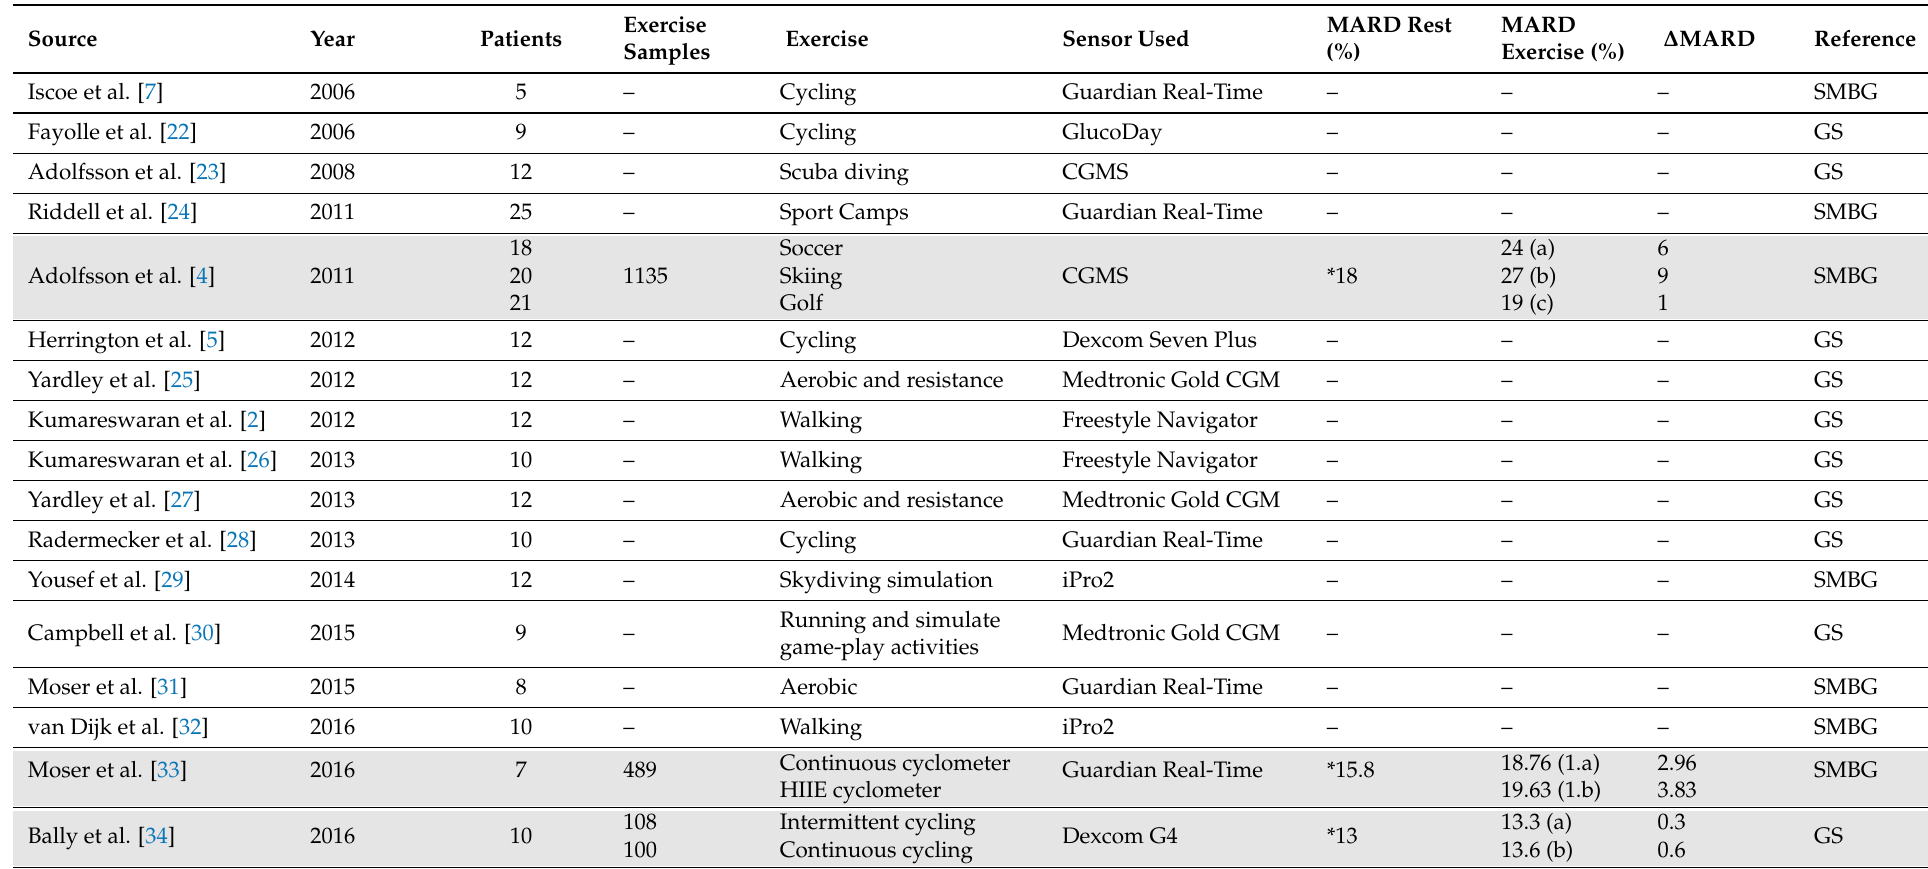
Table 1. Reported data in chronological order of publication of the surveyed studies that carried out exercise trials. GS stands for Gold Standard glucose reference. ∆ MARD = MARD e − MARD r where MARD e is the MARD of the samples within exercise periods and MARD r is the counterpart for the samples during rest periods. Asterisks (*) indicate that MARD r was extracted from the articles mentioned in Table 2. The shaded rows correspond to those papers that reported necessary data to assess sensor accuracy during exercise, 17 in total. The labels that will later be used in the graphics to uniquely identify a study and branch have also been added to the MARD exercise